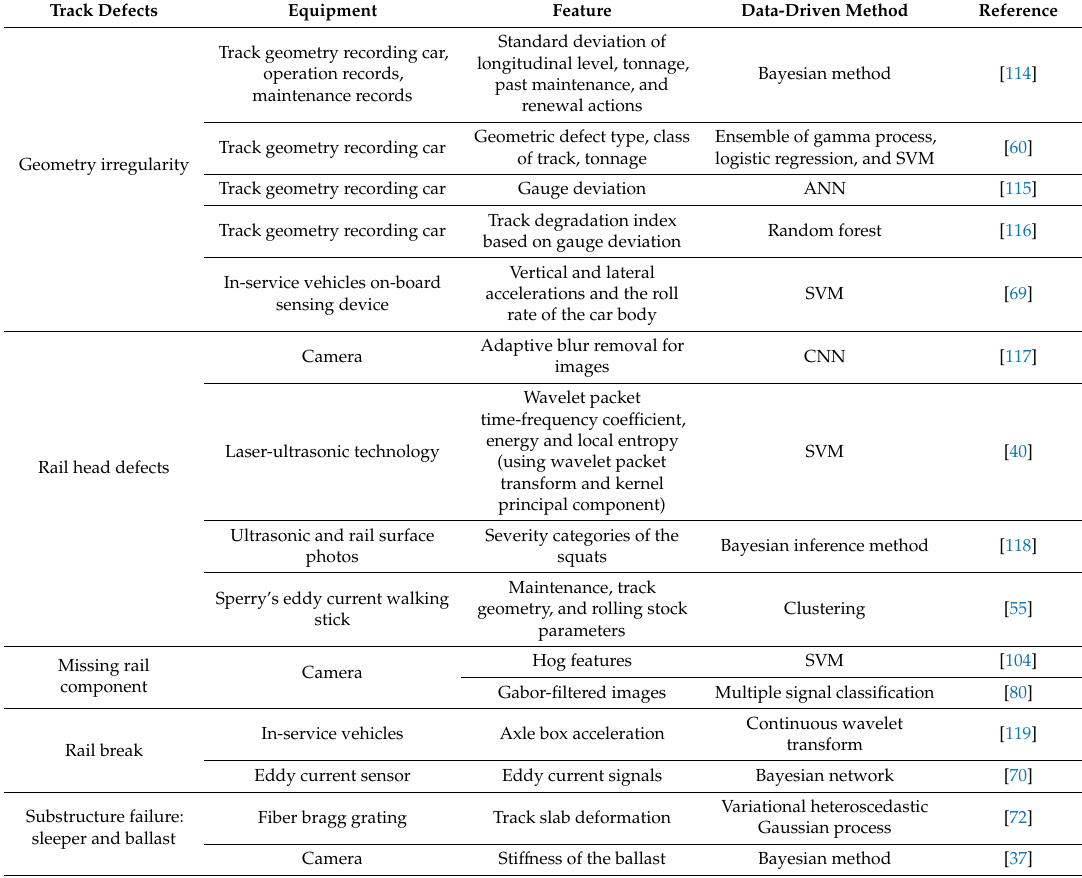
Table 5. A summary of the most recent papers for track